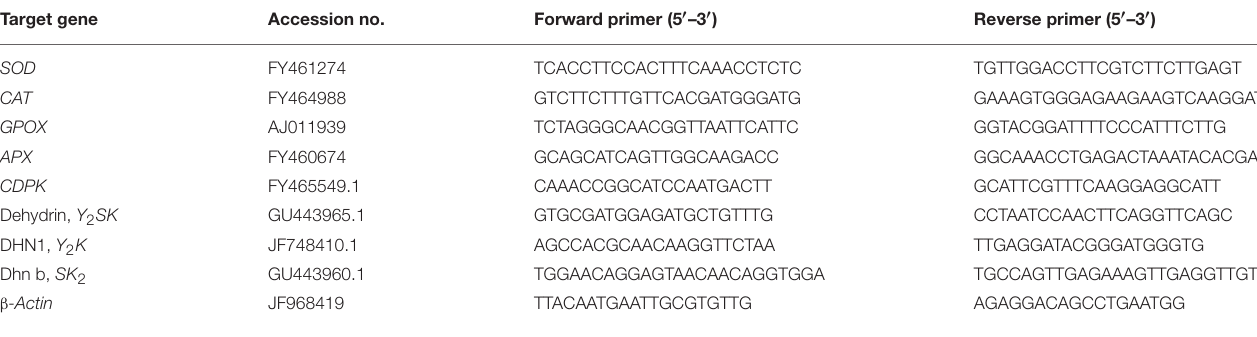
TABLE 1 | Primer sequences and their corresponding GeneBank accession numbers of the analyzed genes. Target